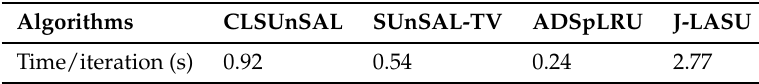
Table 5. Comparison of running times for DS -data